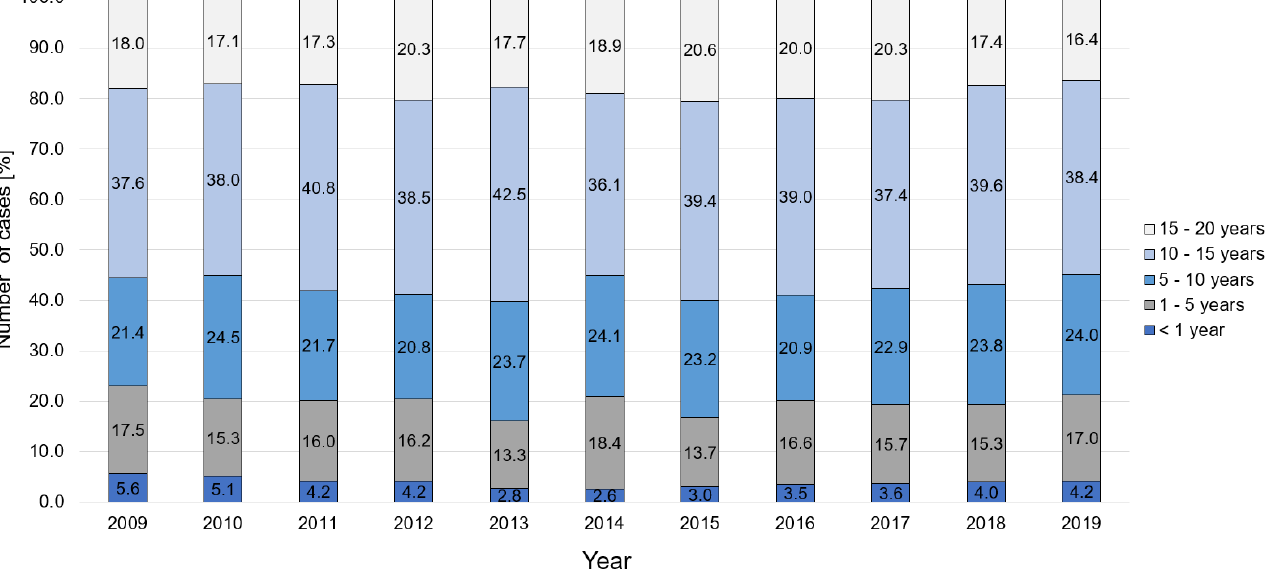
Figure 2. Age-dependent changes in incidence of osteomyelitis cases.